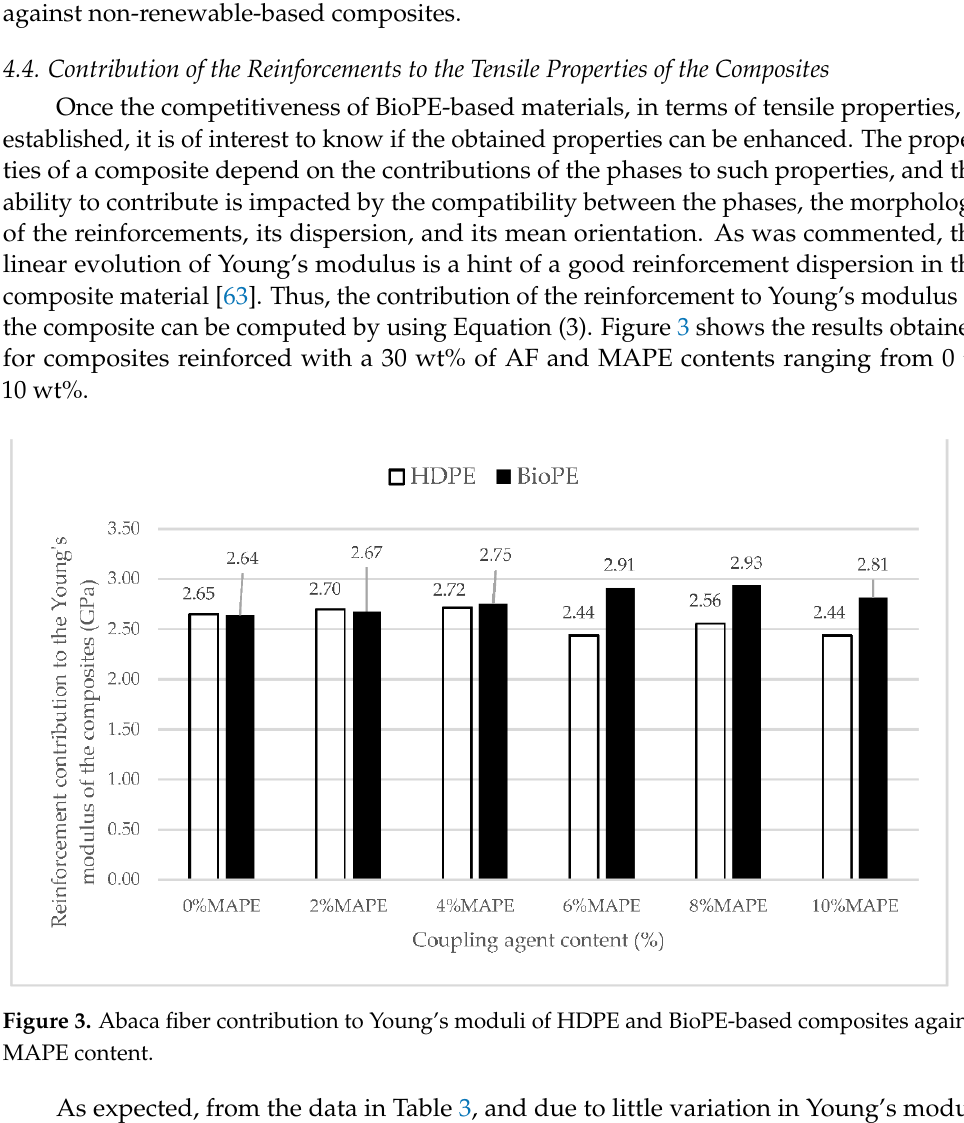
Figure 4. Fiber Tensile Modulus Factor (FTMF) for HDPE and BioPE AF reinforced composites. Figure 4 was used to obtain the FTMF of AF for HDPE and BioPE. The figure shows a linear contribution of AF to Young’s moduli of the composites. The FTMF is obtained as the slope of the regression line of the contributions of the reinforcements against their content. The higher the slope of the line, the higher the contribution of the fibers and, thus, the higher the stiffening abilities of such reinforcement. FTMFs of 11.68 and 13.40 were